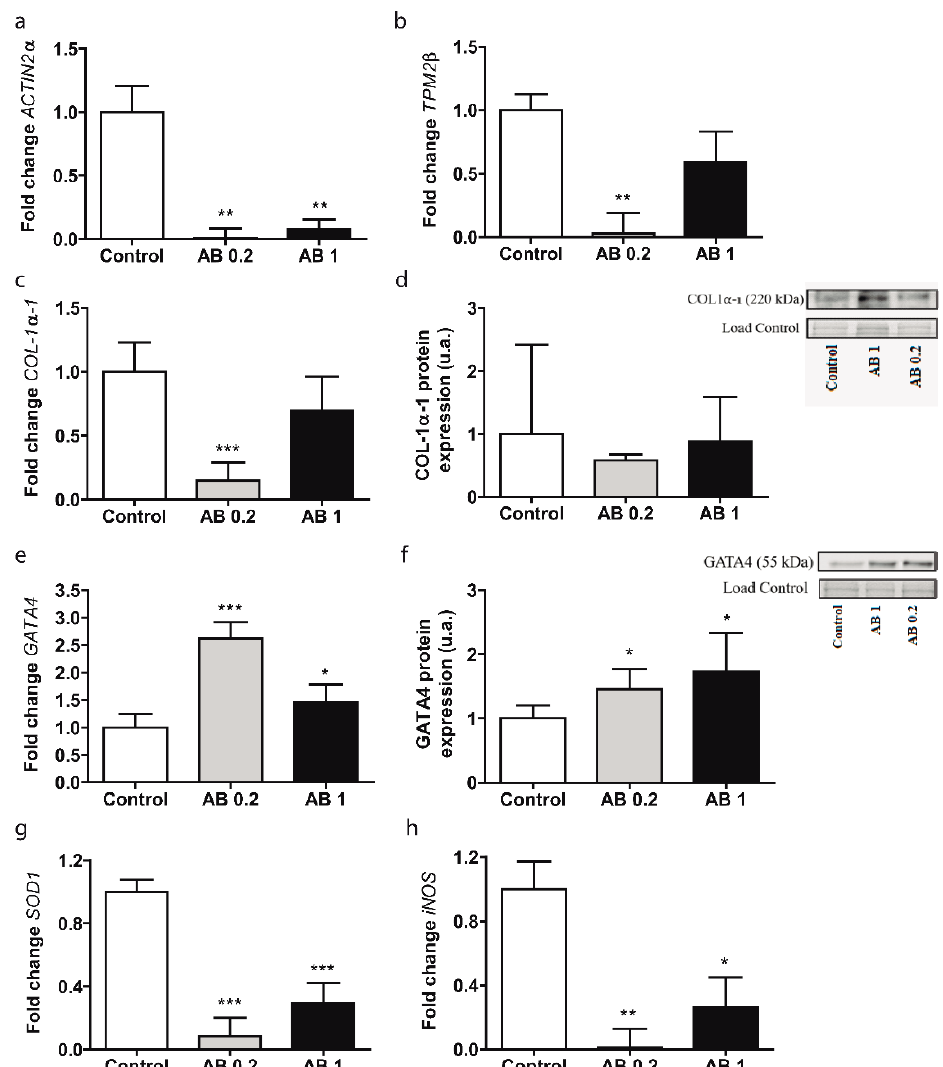
Figure 1. Gene expression levels of fibrotic and oxidative stress markers in LX2 cells treated with 0.2 mg/mL and 1 mg/mL AB extract for 24 h. ( a ) ACTIN-2 α . ( b ) TPM2 β . ( c ) COL1 α 1 . ( d ) COL1 α 1 protein expression levels. ( e ) GATA4 . ( f ) GATA4 protein expression levels. ( g ) SOD1 . ( h ) iNOS . All data are shown as the means ± SD ( n = 5). * p ≤ 0.05 /** p ≤ 0.01/ *** p ≤ 0.001 vs. the control.